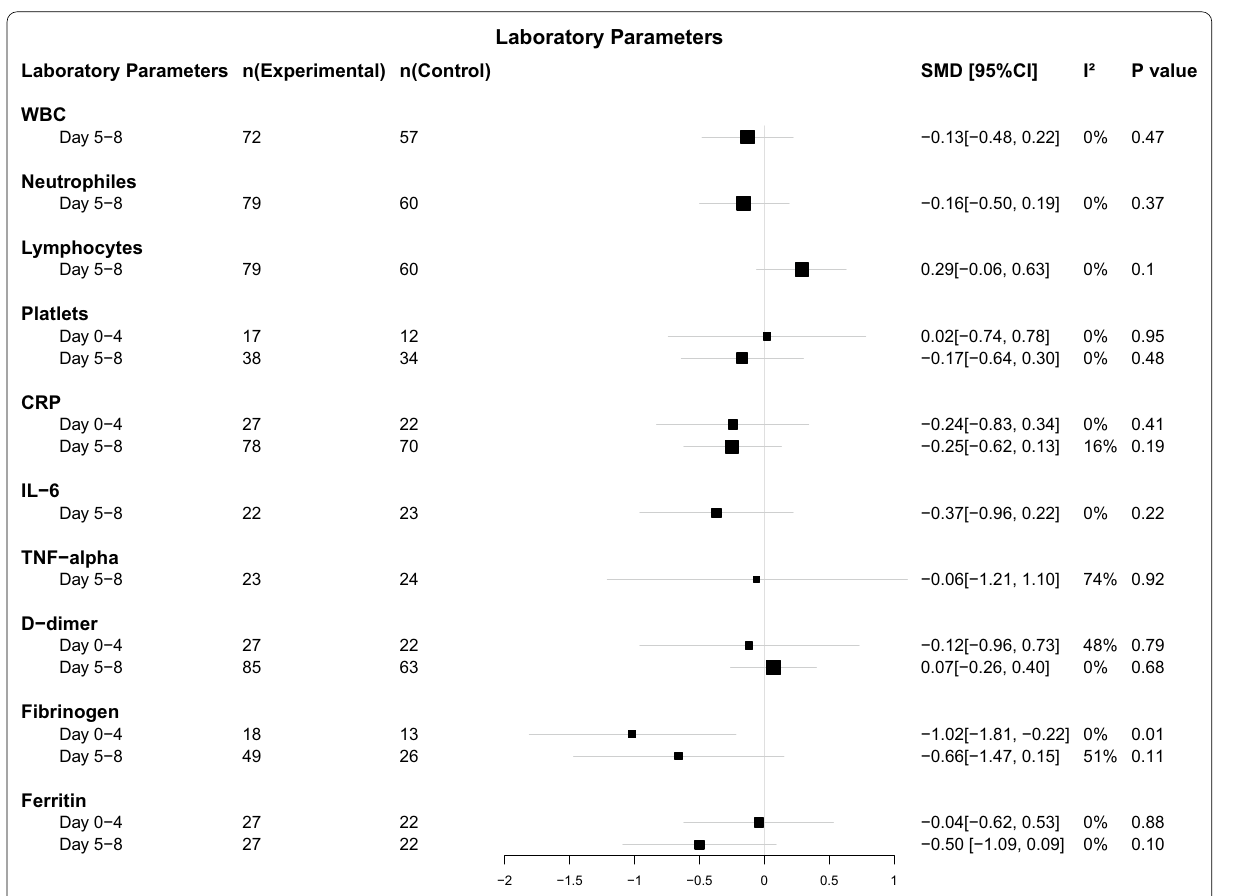
Fig. 6 Forest plot of laboratory parameters: standard mean difference (95% CI) and pooled